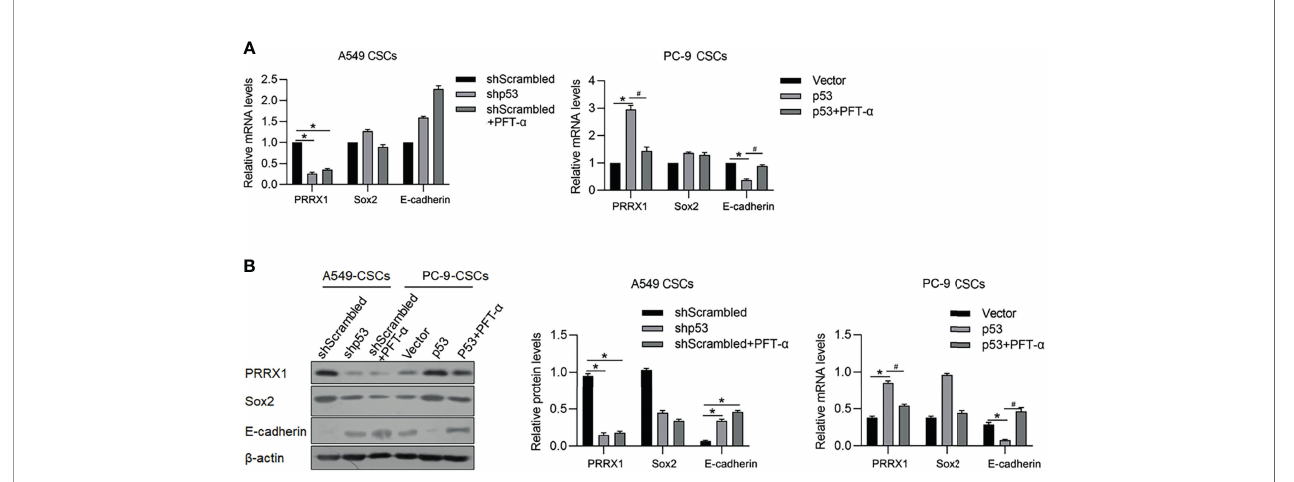
FIGURE 8 | p53 potentially regulates PRRX1, Sox2, and E-cadherin via ALKBH5. In A549 CSCs, p53 was ef fi ciently knockdown by transfecting shRNA targeting p53 mRNA. In PC-9 CSCs, p53 was ef fi ciently overexpressed by transfecting p53-coding plasmid. mRNA (A) and protein (B) of PRRX1, Sox2, and E-cadherin were measured. * p < 0.05 shScrambled group (left panel); * p < 0.05 vs. vector group; # p < 0.05 vs. p53 group (right